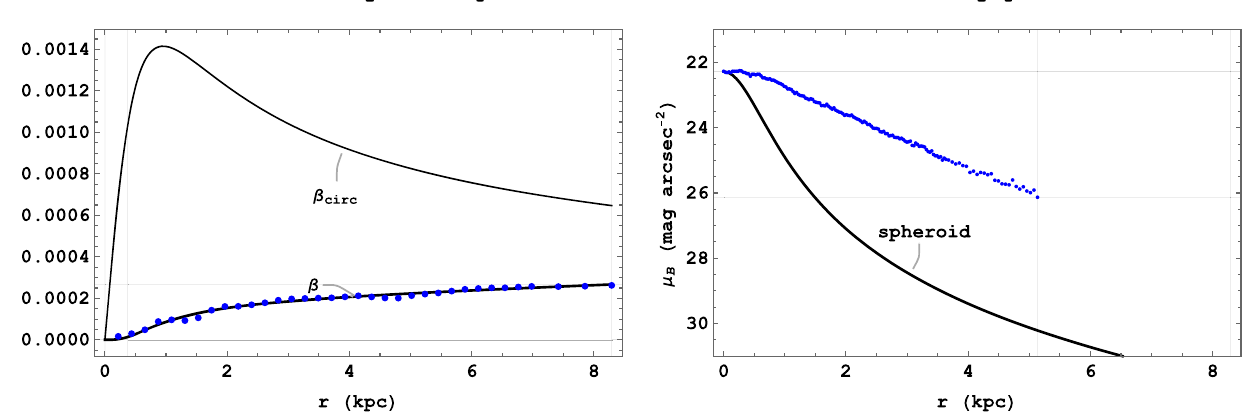
NGC 1560, as listed by Broeils [32] and represented by dots. The mea- sured luminosity profile extends to the maximum radial distance 5.13